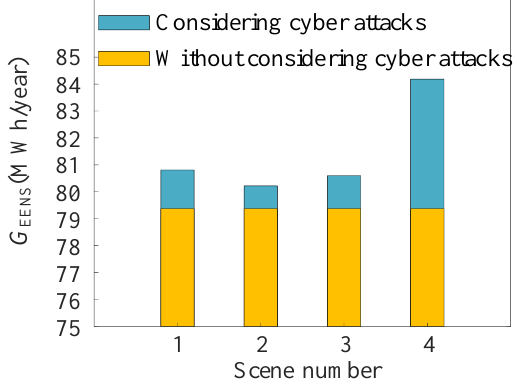
Figure 17. Impact of attacking one IED on G EENS .